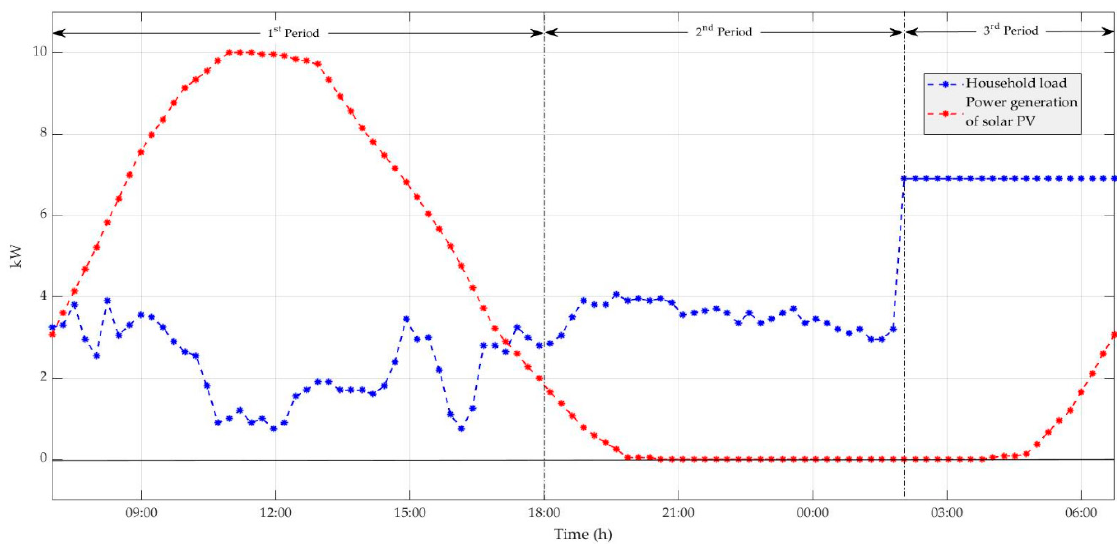
Figure 4. Daily power generation of the solar PV system and household load profile.